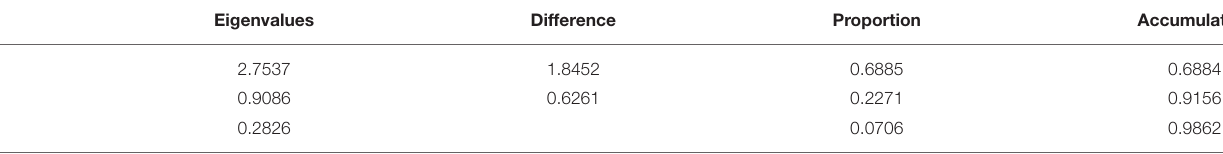
TABLE 2 | Eigenvalues of the correlation matrix and its cumulative contribution to variance.